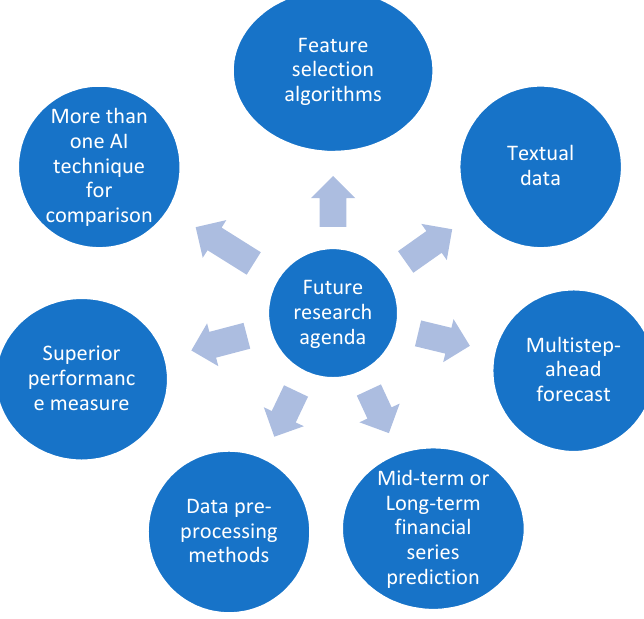
Figure 4. Future research agenda.